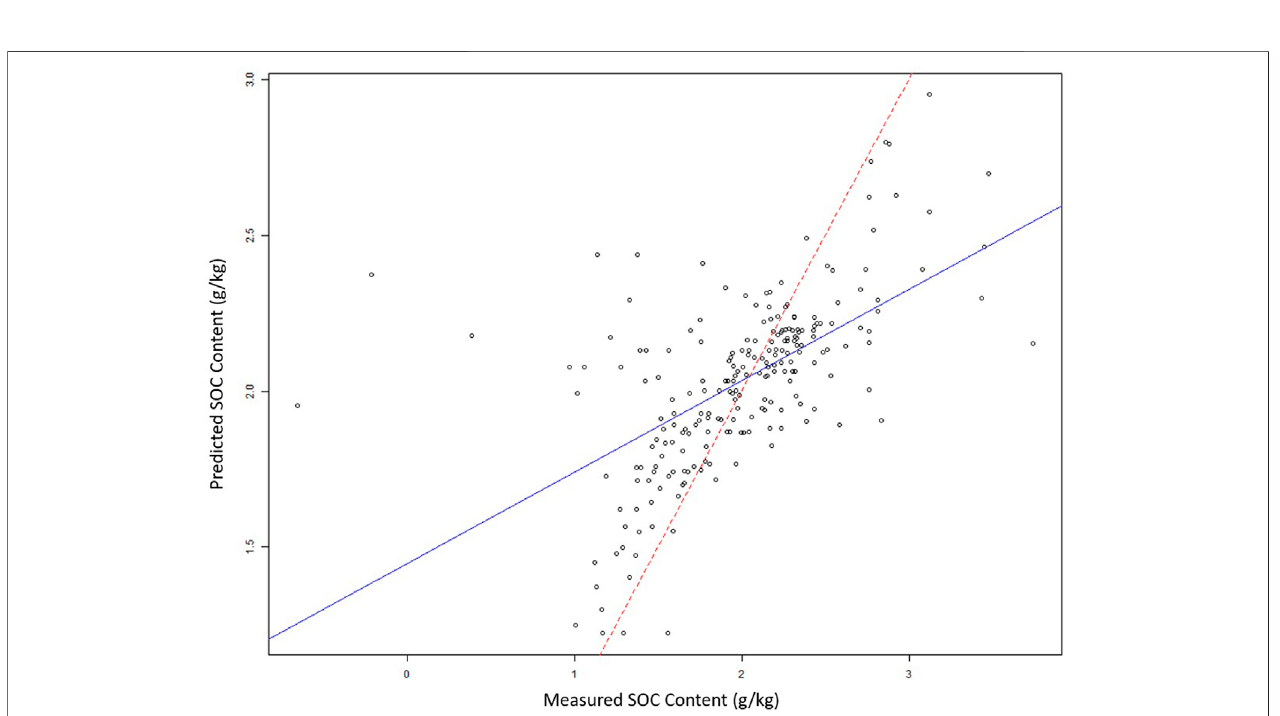
FIGURE 3 | Diagnostic comparison of the predicted and observed SOC content (g kg − 1 ), with the line of perfect fi t (red) and best line of fi t (blue).